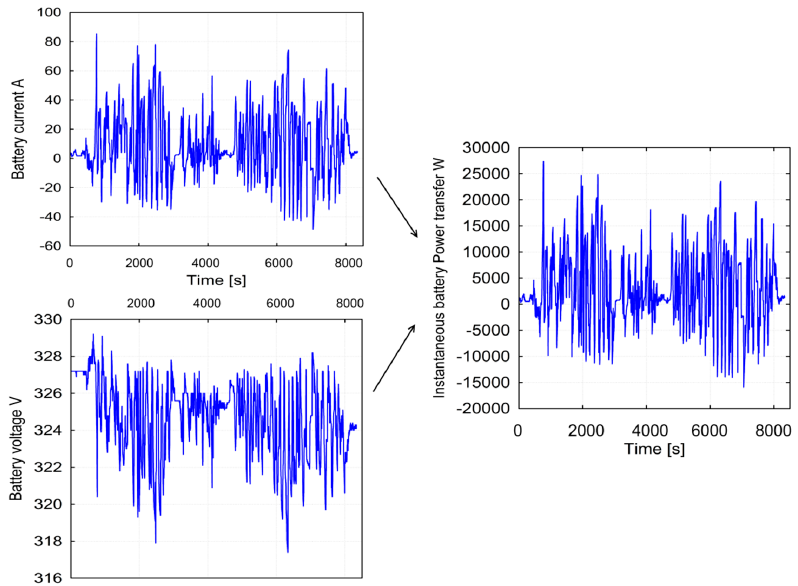
Figure 10. Determining the instantaneous battery power transfer W for one discharge cycle from battery voltage and current measurements. battery voltage and current